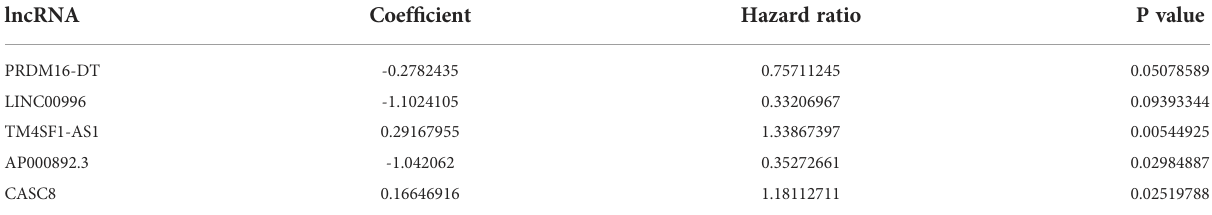
TABLE 3 Multivariate Cox proportional hazard regression analysis of the 22 prognosis-related DE lncRNAs further narrowed down to 5 DE lncRNAs that are independently associated with the overall survival of pancreatic cancer patients.